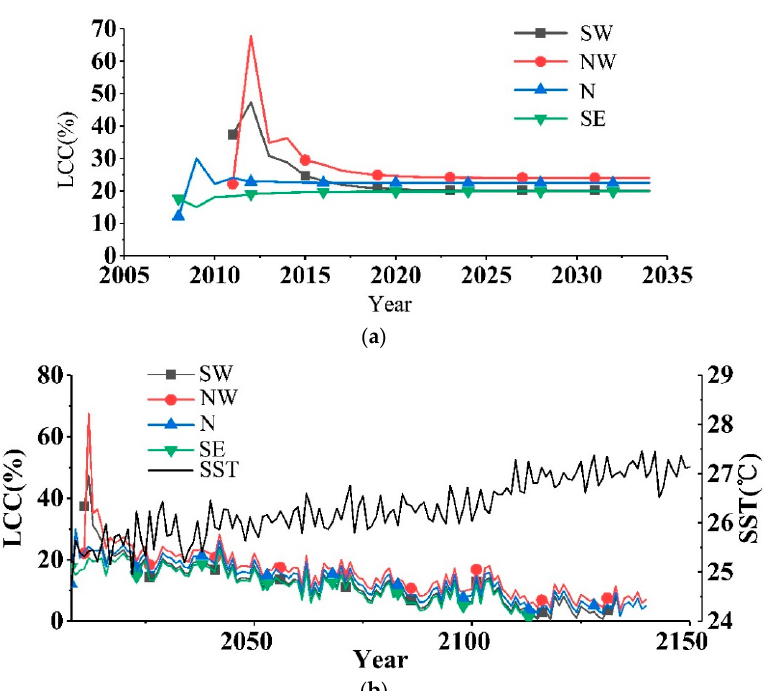
Figure 6. Developments of the LCCs around Weizhou Island under the conditions of ( a ) constant environmental parameters and ( b ) constant environmental parameters except for the raising of SST.